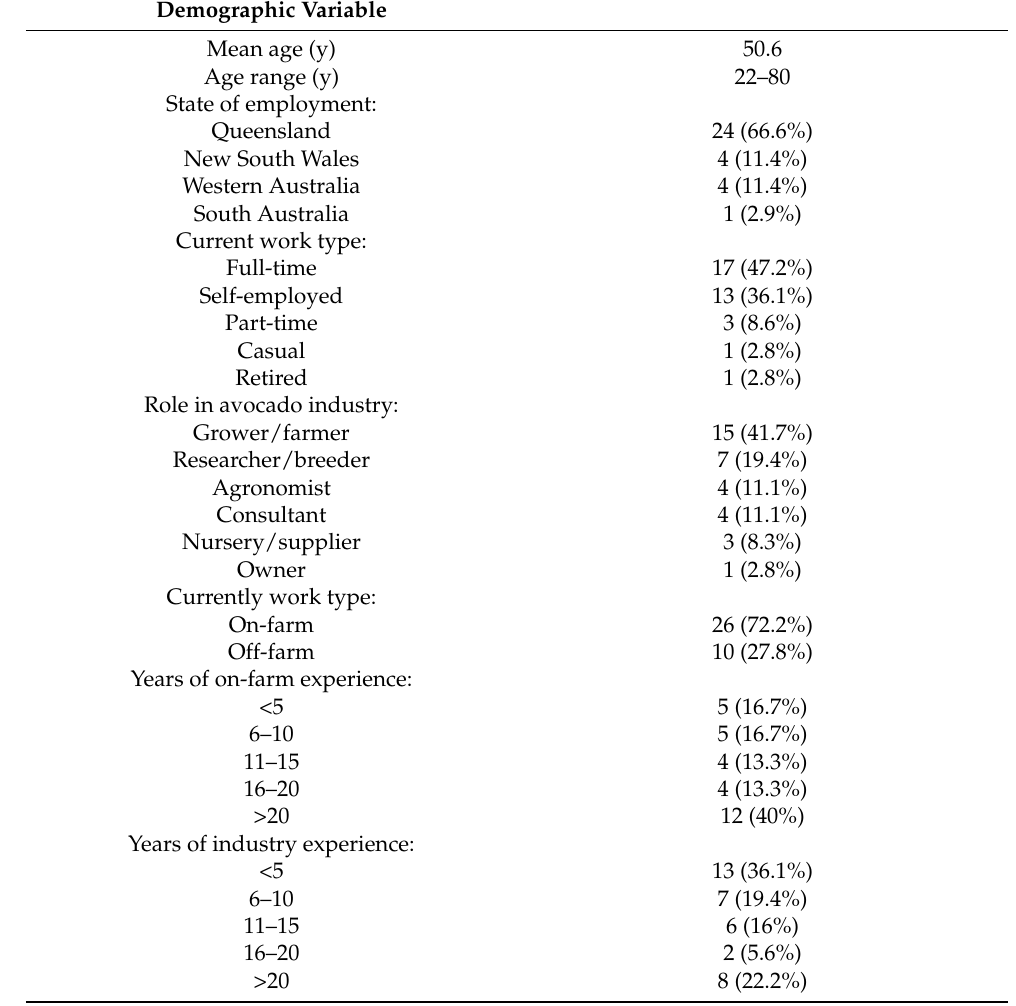
Table 1. Participant characteristics ( n =